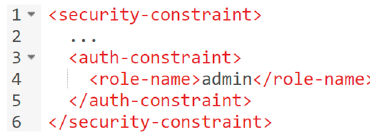
Figure 8. Developers may use a deployment descriptor for RBAC.